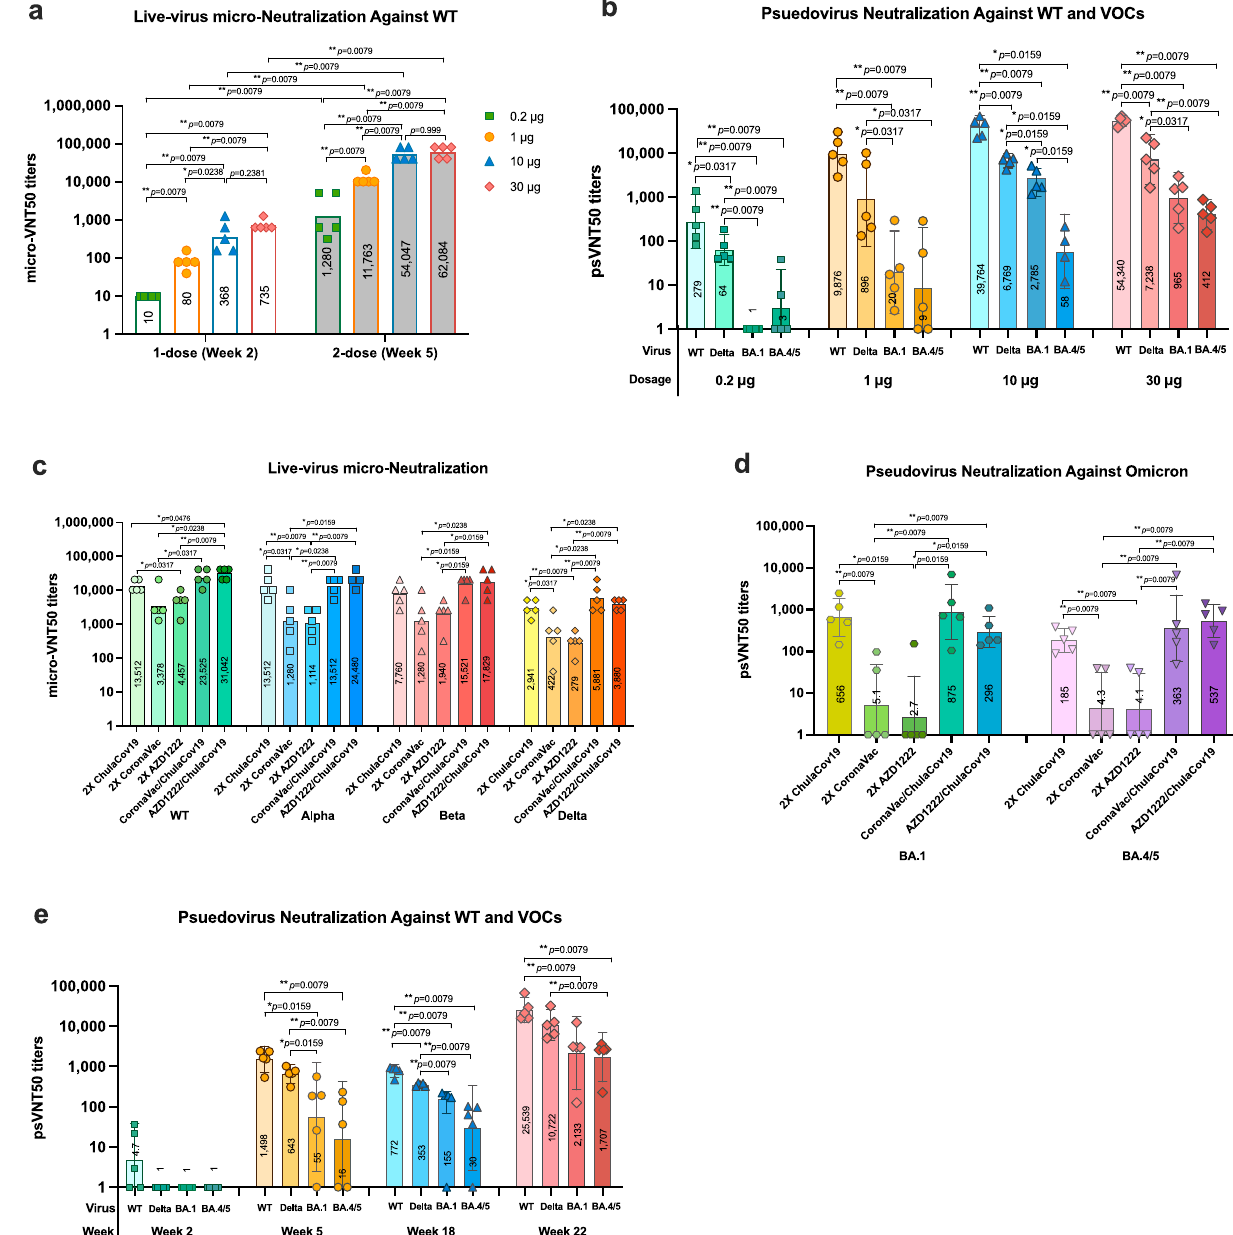
Fig. 4 | NAb responses in immunized mice. Experiment 1: ( a ) Live-virus micro- neutralization (micro-VNT50) titers against WT (Wuhan-Hu1) live-virus at two weeks after receiving each vaccine dose. b Pseudovirus neutralization test (psVNT50)titersattwoweeksaftertheseconddoseagaintWT(Wuhan-Hu1),Delta (B.1.617.2),Omciron(BA.1,andBA.4/5)variants.Experiment2: c micro-VNT50titers against WT (Wuhan-Hu1), Alpha (B.1.1.7), Beta (B.1.351), and Delta (B.1.617.2) live- virus at two weeks after receiving various homologous or heterologous prime/ boostregimens. d psVNT50NAb titerresultsattwoweeksaftertheseconddosein various prime/boost regimens againt Omicron BA.1 and BA.4/5 subvariants.